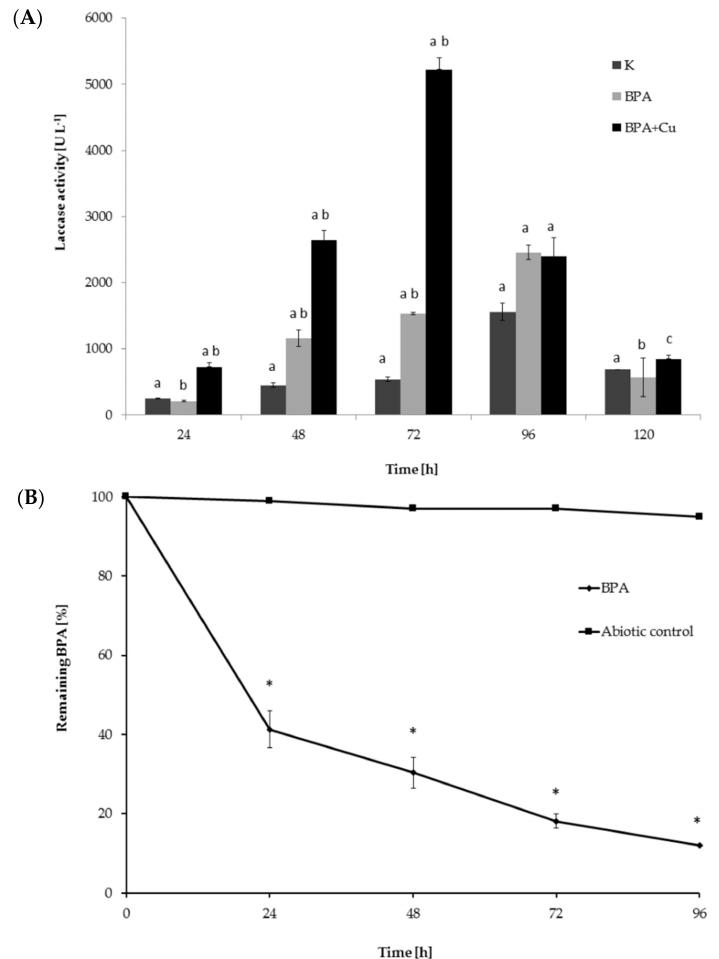
Figure 2. ( A ) Laccase activity in M. roridum cultures cultivated in Czapek-Dox III medium with BPA (50 mg · L − 1 ), BPA (50 mg · L − 1 ) and copper sulfate (1 mM) or without BPA supplementation. ( B ) BPA removal from water solution by crude laccase of M. roridum (1 U · mL − 1 ). Letters and asterisks repre- sent values with statistically significant differences determined with a one-way ANOVA followed by the Tukey test ( α = 0.05) for different